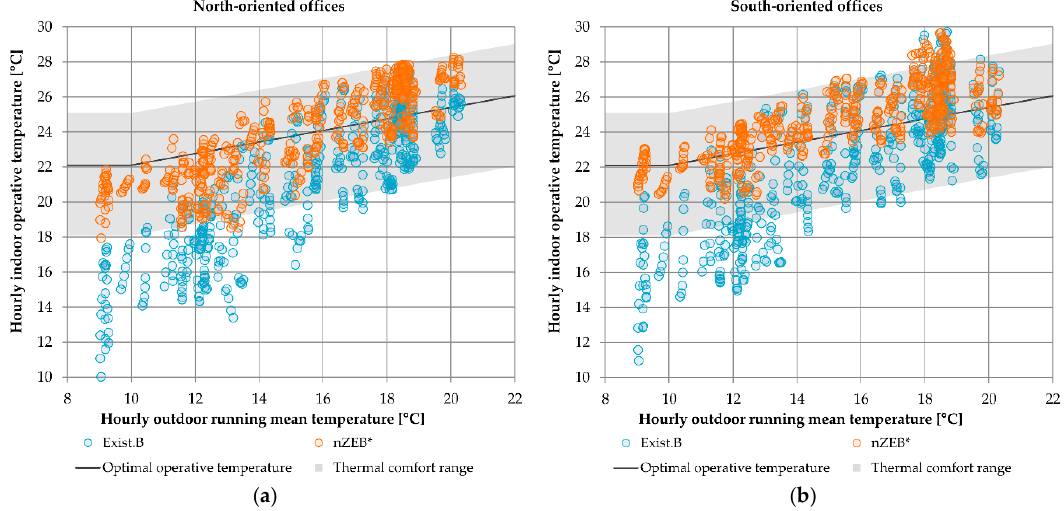
Figure 5. Thermal comfort analysis results; comparison between the building storey in the current condition (Exist.B) and considering the retrofitting of the building envelope (nZEB*): ( a ) North-oriented offices; ( b ) South-oriented offices.